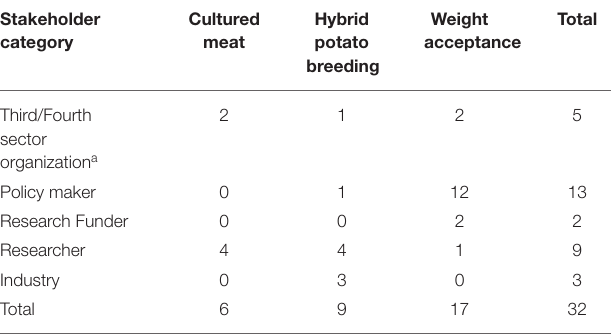
TABLE 1 | Participants by case